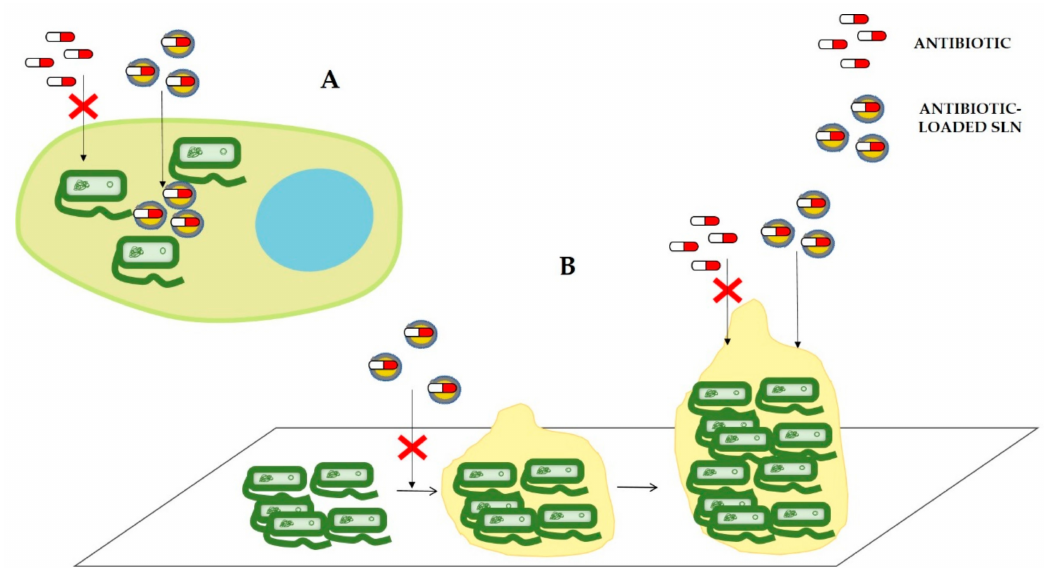
Figure 5. Schematic representation of community antibiotic resistance strategies and the effect of antibiotic incorporation into SLNs to avoid them. ( A ) Intracellular infection and ( B ) biofilm formation. In both cases, how can antibiotic-loaded SLNs overcome these strategies is represented. SLNs can improve eukaryotic cell uptake to treat intracellular infections. SLNs can reduce biofilm formation or viability of biofilm-forming